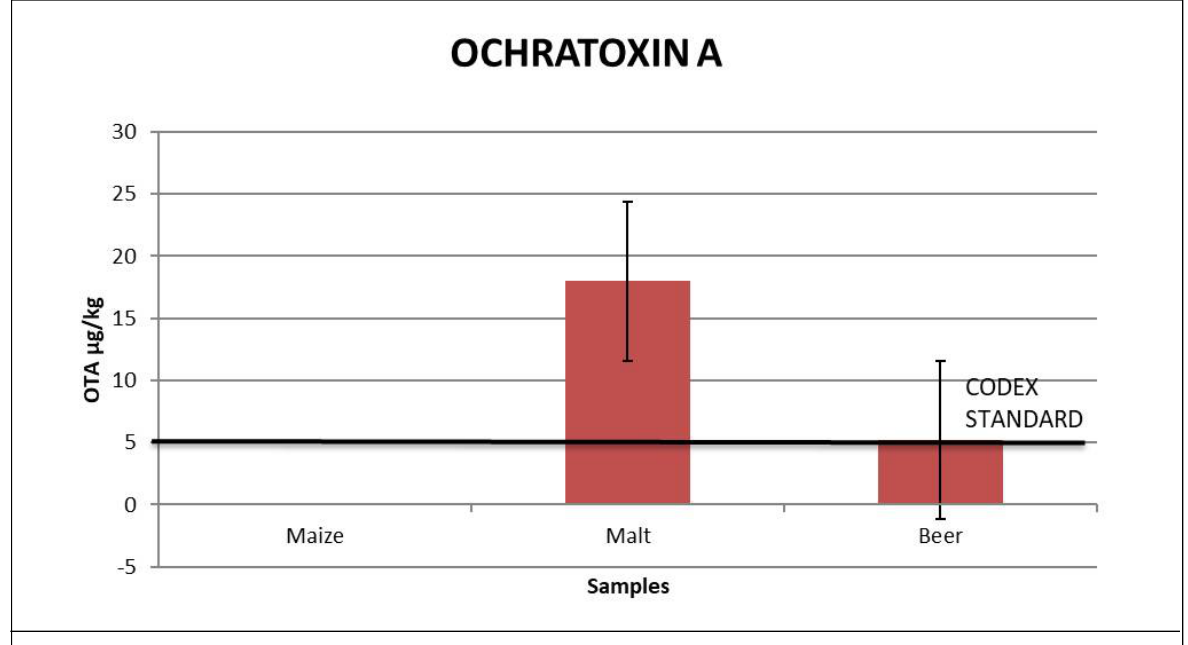
Figure 5: Levels of OTA in maize, malt and